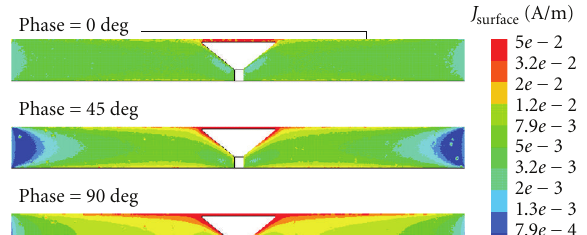
Table 3: Characteristics of gravure printable ink.